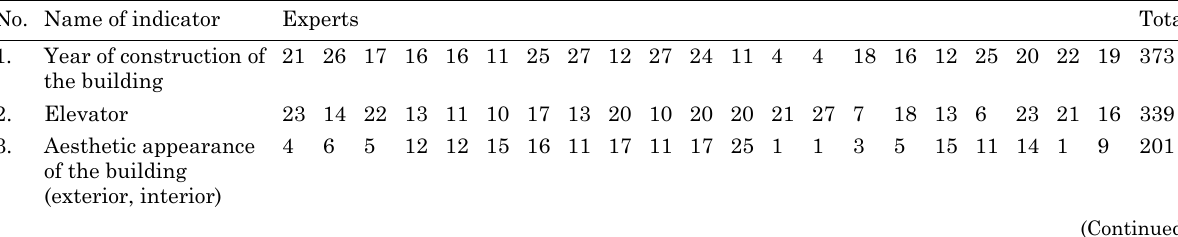
table 3. results of ranking of importance of premises lease